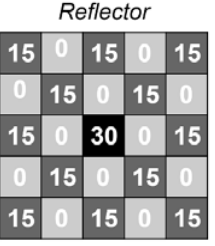
Figure 1: Burnup map at beginning of cycle, values relative to the fuel assembly in